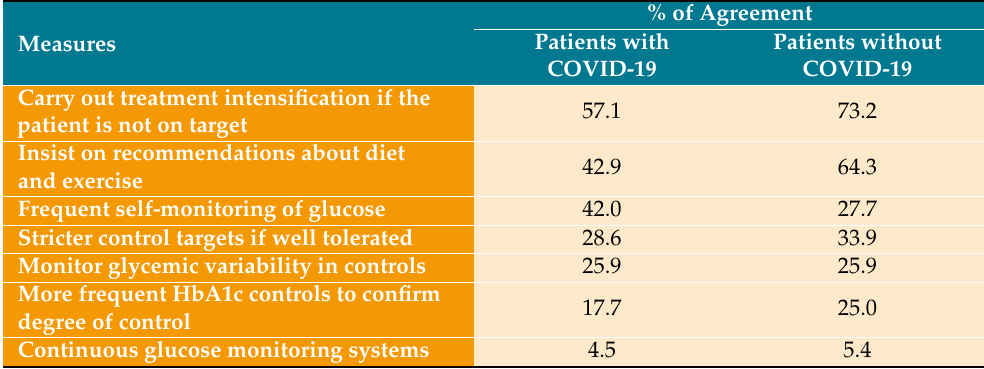
Table 3. Opinion on measures incorporated in clinical practice for the optimization of glycaemic control in ambulatory patients with T2DM ( n =